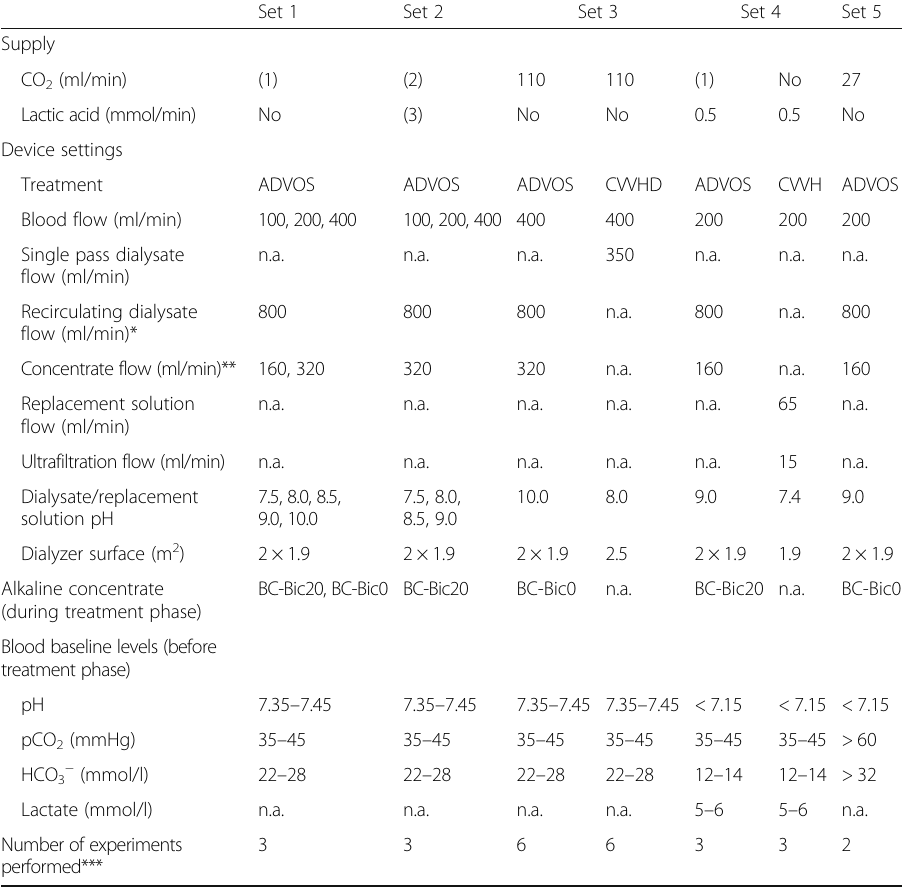
Table 1 Experimental setting for each of the tests performed Set 1 Set 2 Set 3 Set 4 Set 5 Supply